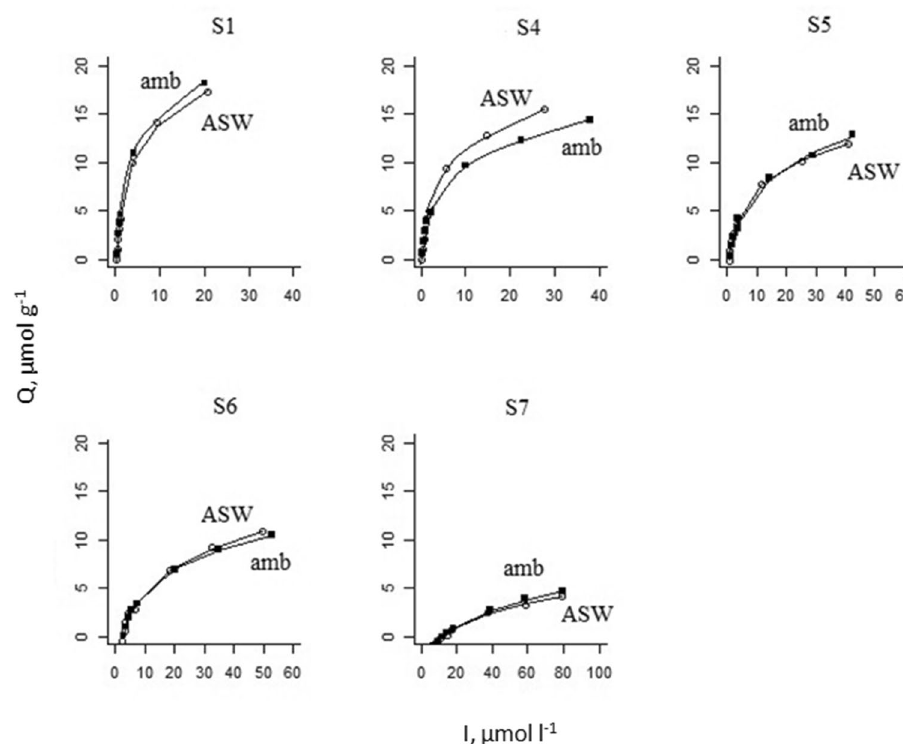
Fig. 4 Isotherm graphs of sediments S1 and S4 − S7 equilibrated in ambient water (amb; filled symbol) and in ASW (open symbol). Graphs were plotted using the aver- age values of the replicates. I = equilibrium P concentration, Q = amount of P desorbed from or sorbed onto the